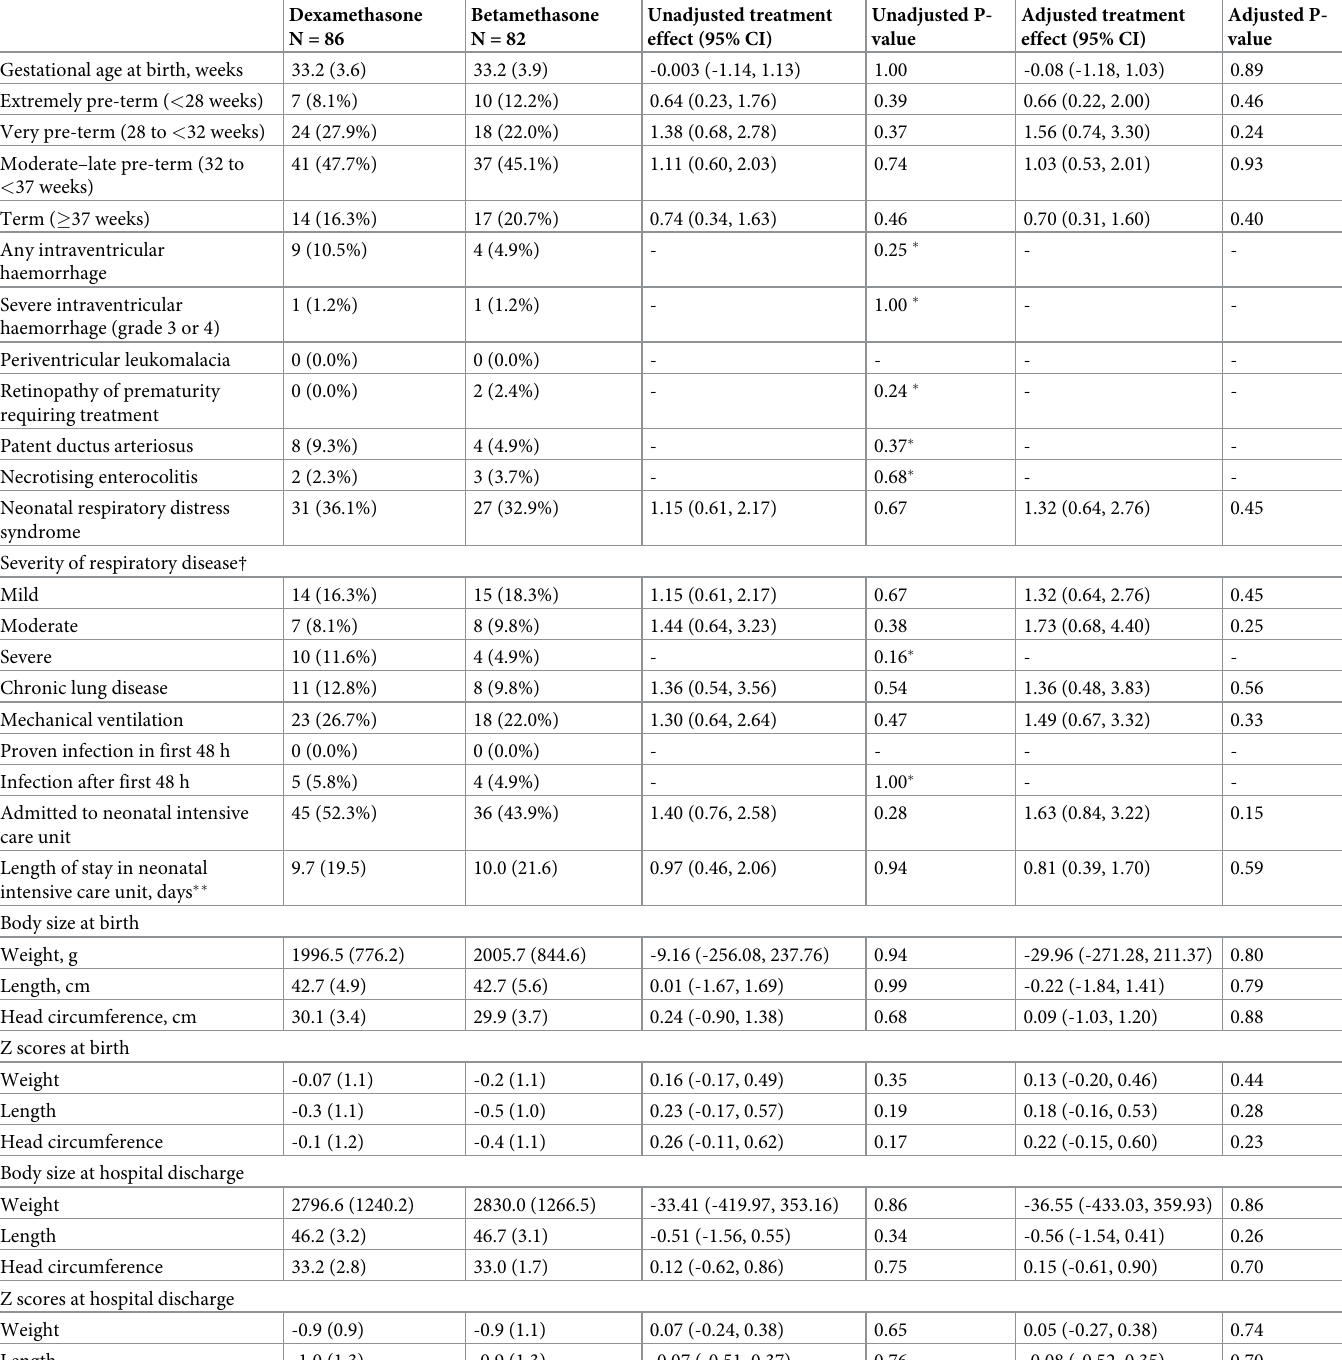
Table 3. Secondary outcomes for live born infants assessed before hospital